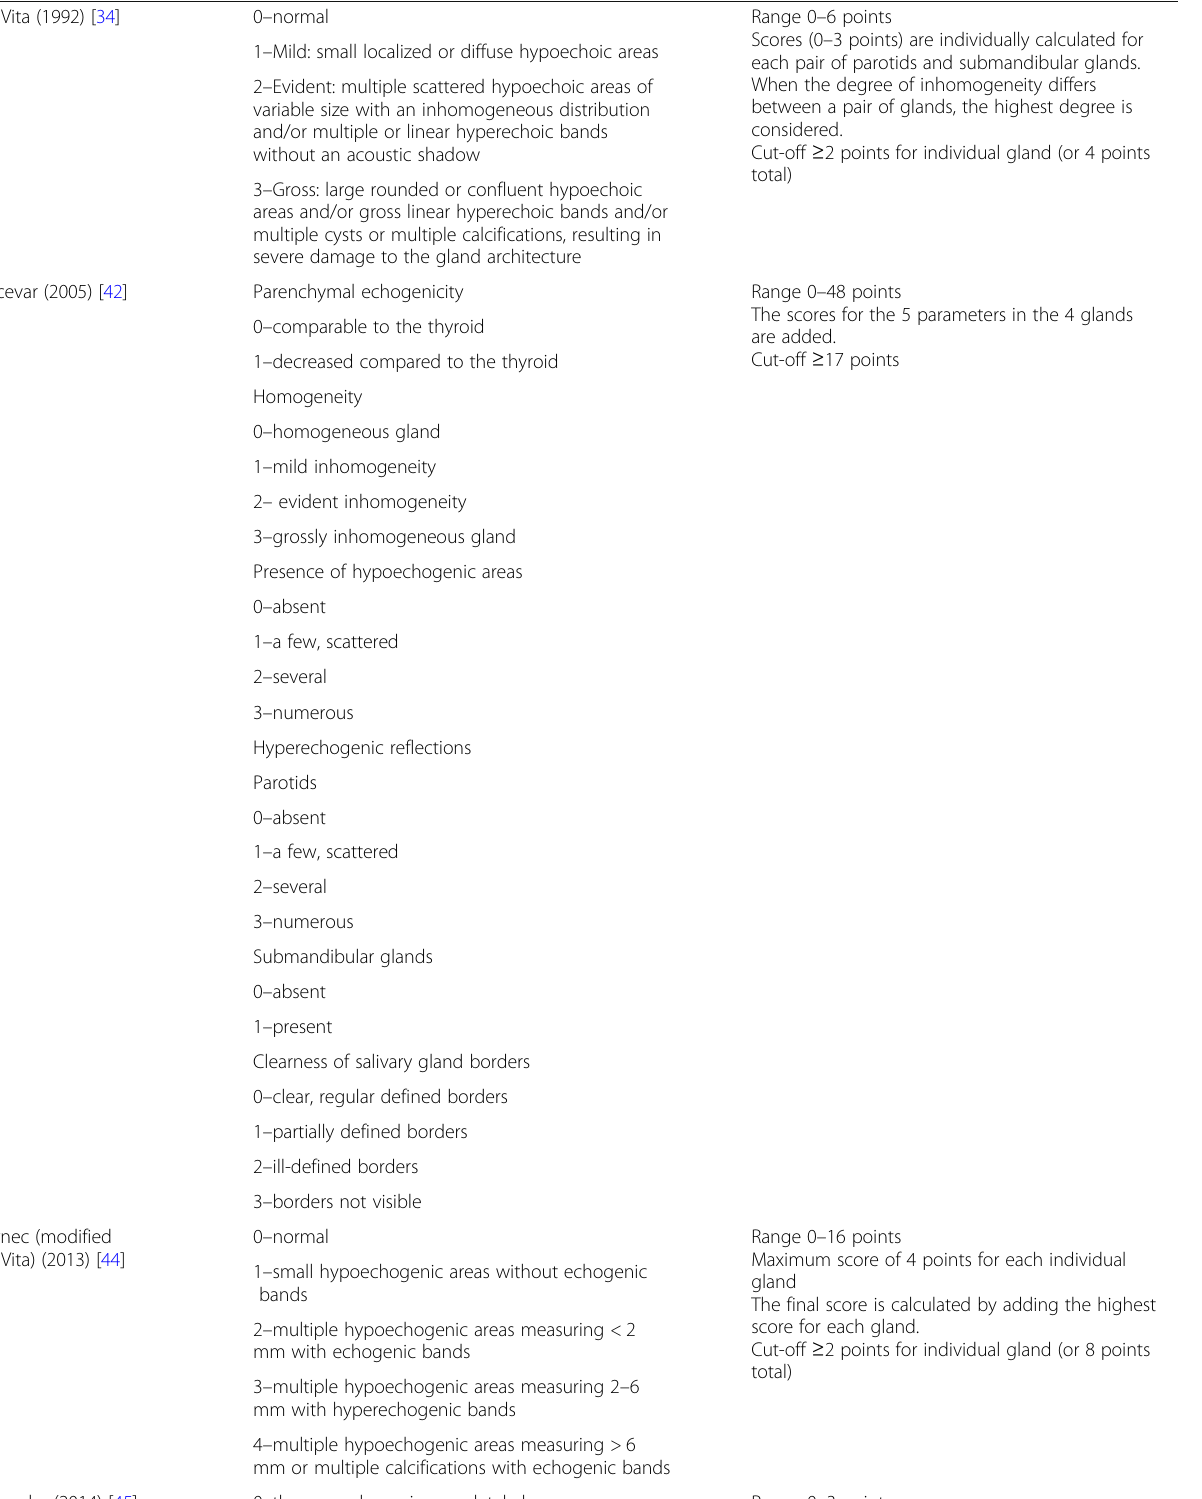
Table 5 Scoring systems for salivary gland ultrasound findings in patients with Sjögren ’ s syndrome, considering the bilateral submandibular glands and parotid